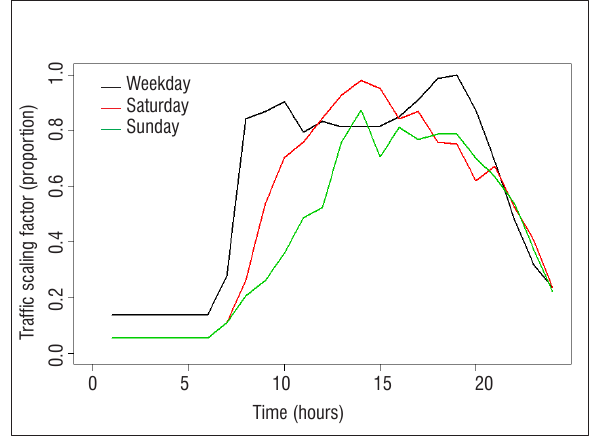
Plot of the scaling factors used to convert peak hour traffic hours on a weekday into traffic hours at different times of the day during the week, on Saturdays and on